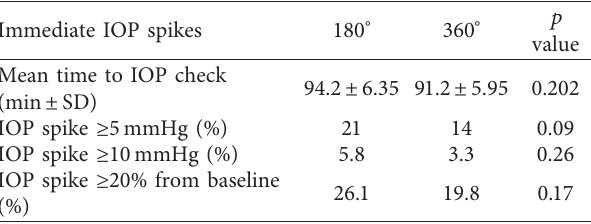
Table 4: Comparison of immediate IOP spikes and mean time to IOP